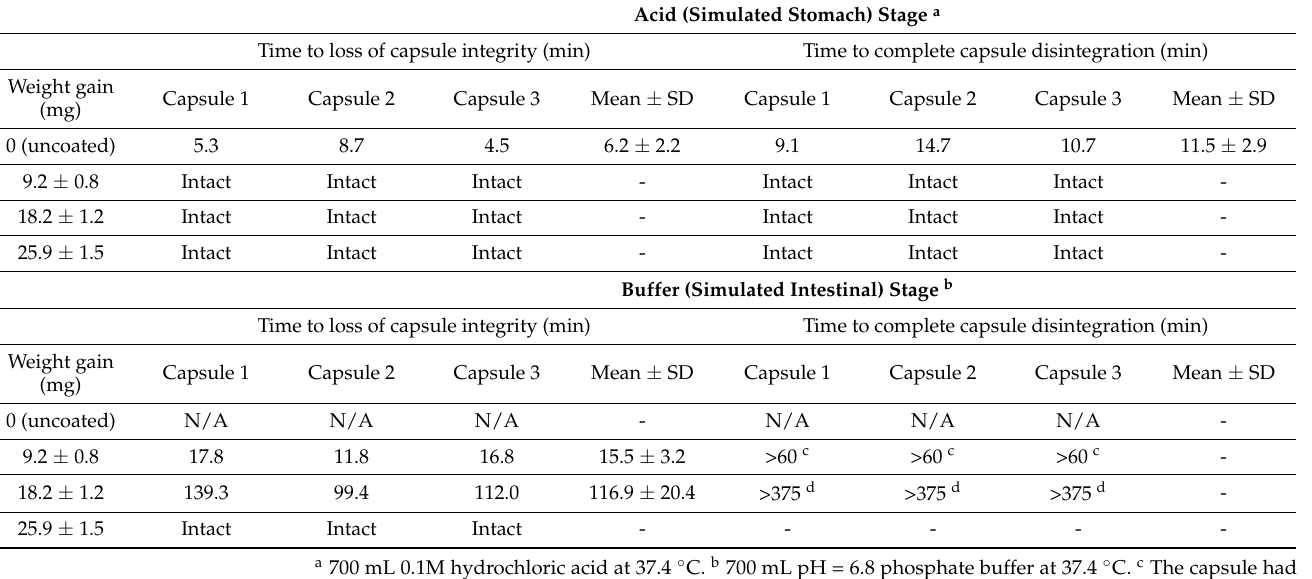
Table 1. Disintegration tests of capsules with different amounts of coating in acid (simulated stomach) and buffer (simulated intestinal)